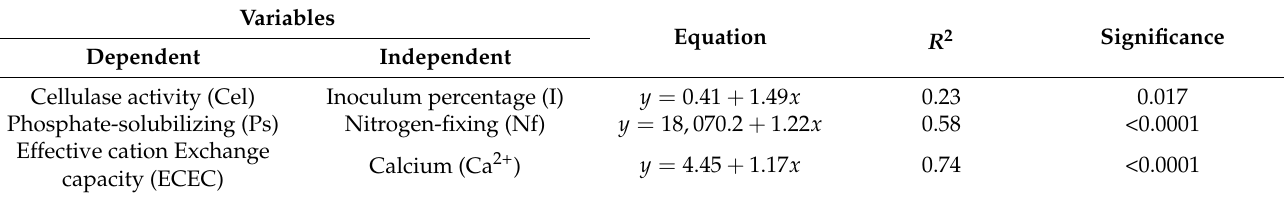
Table 4. Results of the simple linear